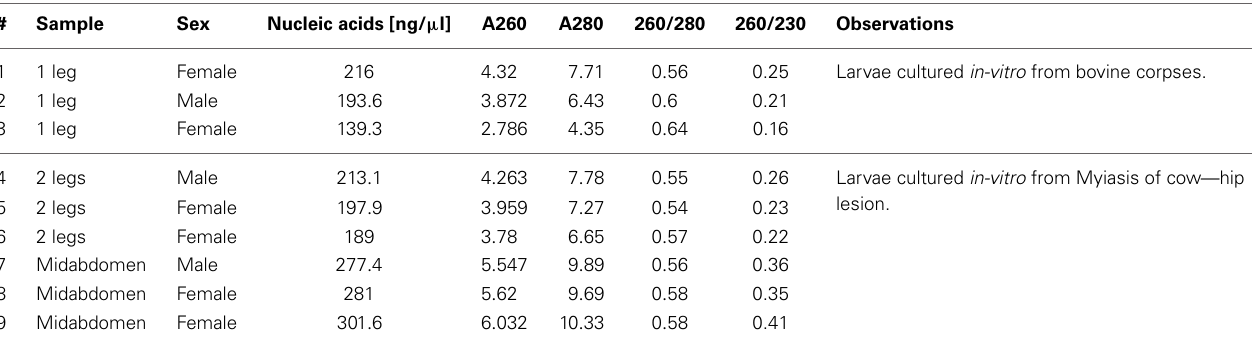
Table 2 | Results of DNA quantifications from samples of Cochliomyia spp., collected in